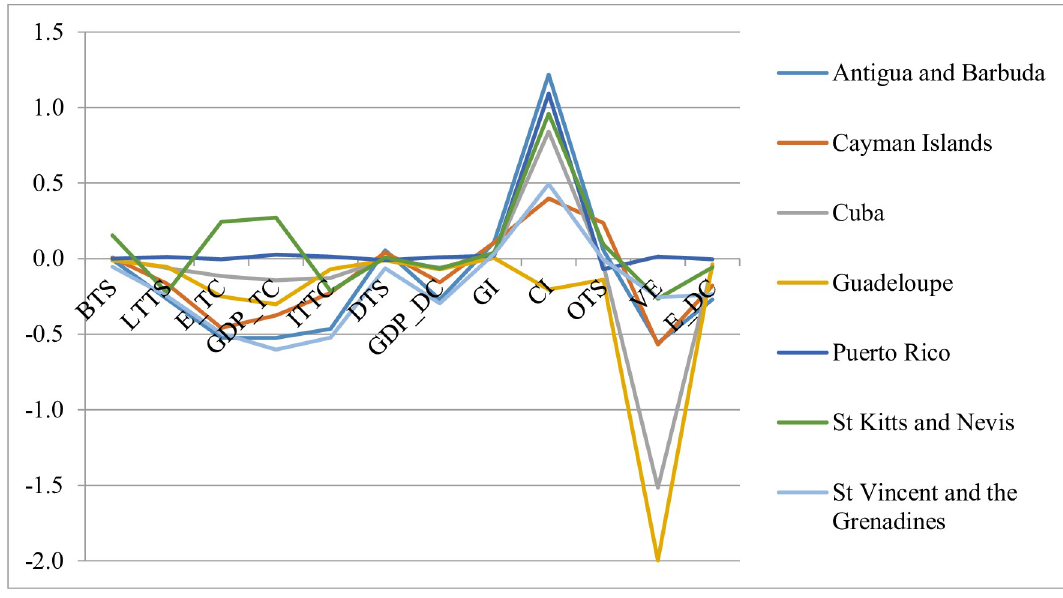
Fig 3. Slopes for 4 th